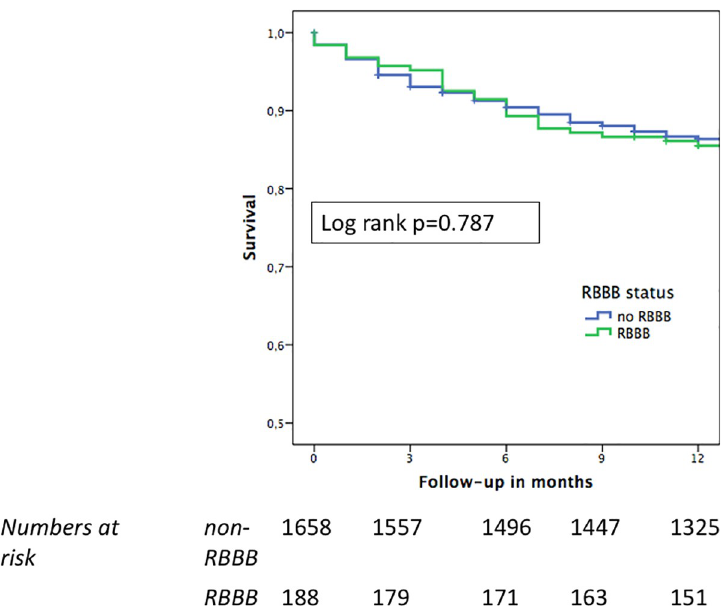
Fig 1. Kaplan-Meier estimates for one-year survival in patients with baseline RBBB versus no RBBB. During a follow-up time of 12 months, no difference in survival was observed between RBBB and non-RBBB patients. Abbreviations: RBBB = right bundle branch